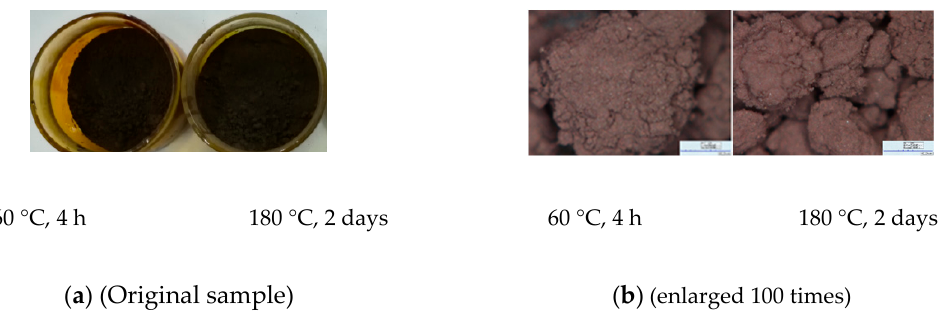
Figure 4. The apparent morphology of KNO 3 compared before and after different temperature tests.